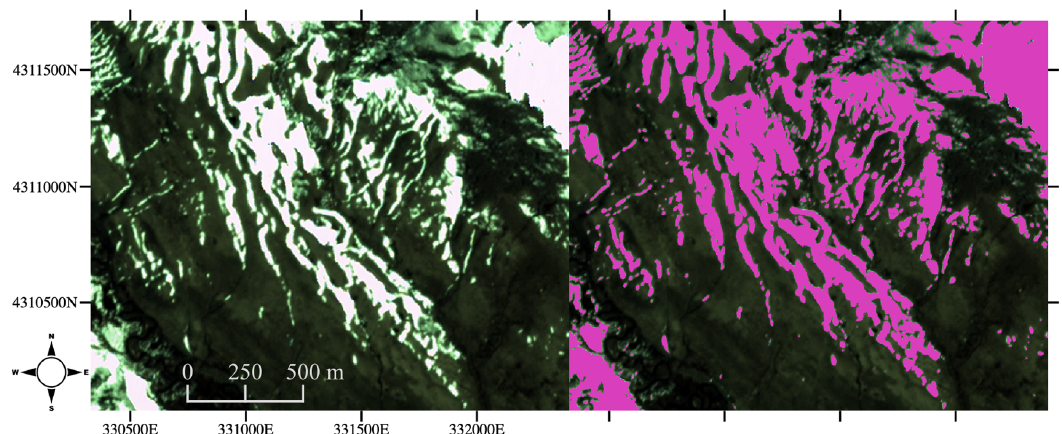
Figure 5. A true color image ( left ) compared with snow classification results ( right ) from PlanetScope satellite imagery of the East River watershed on 11 May 2017. Pixels classified as snow are displayed in pink.